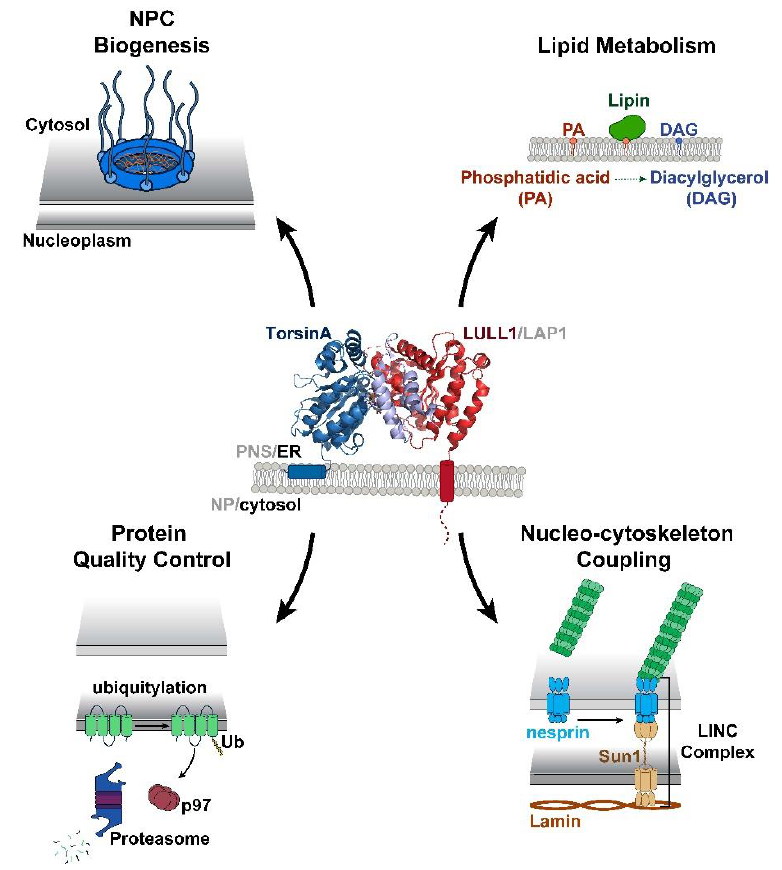
Figure 1. Torsins are implicated in multiple essential cellular processes at the nuclear envelope (NE) and endoplasmic reticulum (ER). The ability of Torsins to participate in these diverse cellular activities relies upon their capacity to efficiently bind and hydrolyze ATP. This ATPase activity is mediated through an active site complementation mechanism in which one of two cofactors contributes a catalytic arginine residue to the active site. Shown is a side view of TorsinA (blue) complexed with the ER-specific cofactor luminal domain like LAP1 (LULL1) (red) (PDB: 5J1S) [12]. The TorsinA RecA fold composed of residues 55–221 is shown in dark blue and the C-terminal α-helical bundle (residues 272–332) is shown in light blue. The LULL1 luminal domain, residues 249–470, is represented in red.